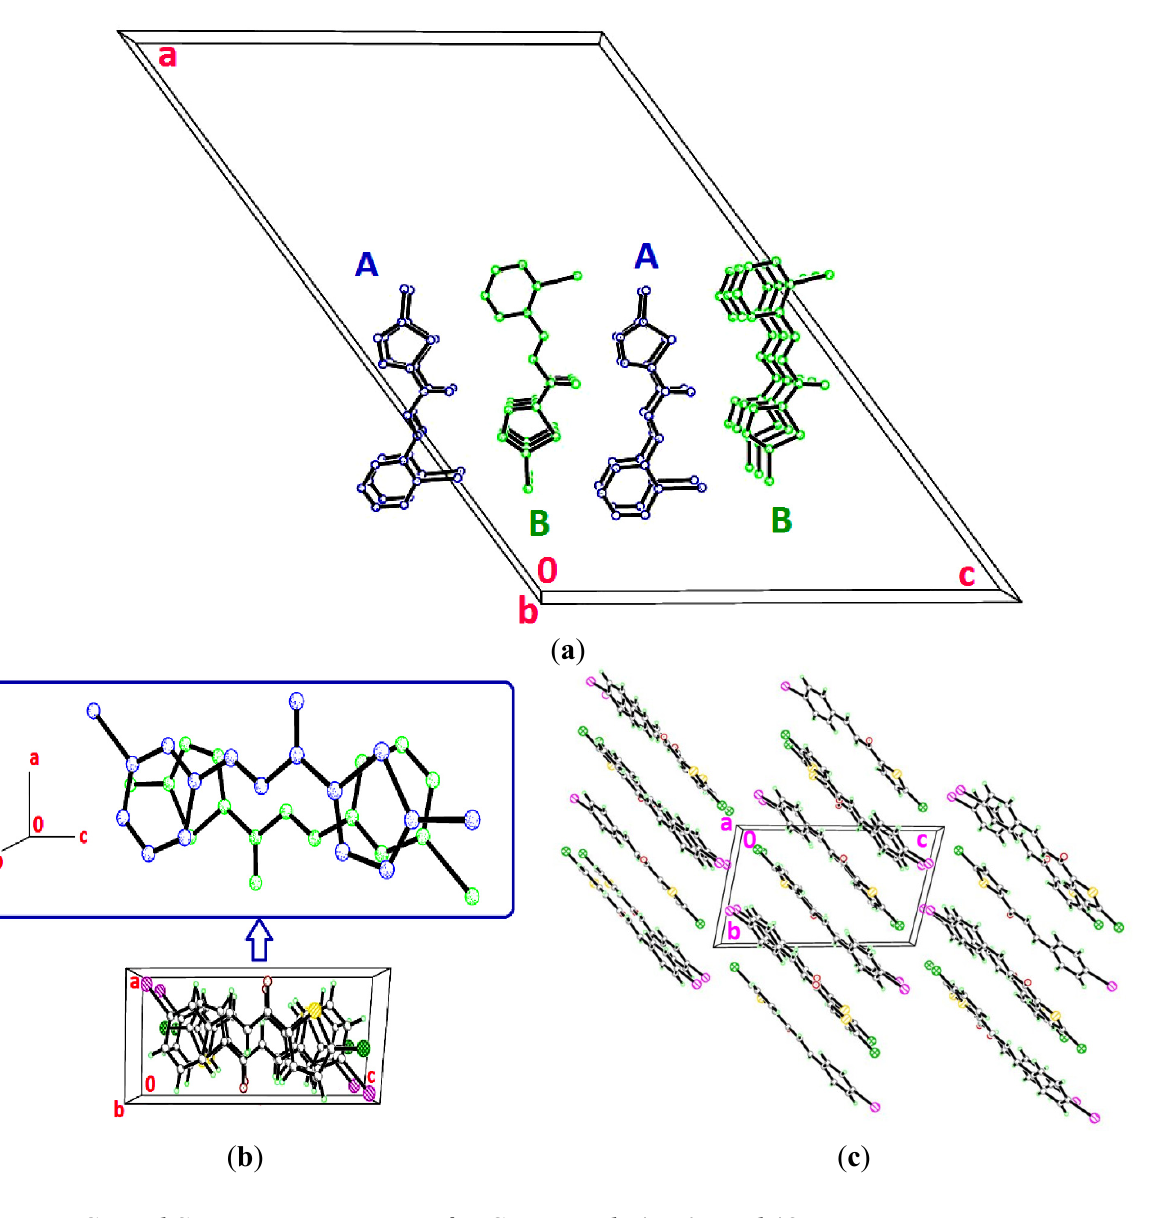
Figure 4. ( a ) Crystal structure of 4a with molecule A represented in blue and molecule B in green, stacking along the b -axis. Hydrogen bonds have been omitted for clarity. ( b ) Packing diagram of 4b, showing the stacking in an inverse fashion. ( c ) Crystal structure of 4c, displaying the stacking of molecules along the (110)